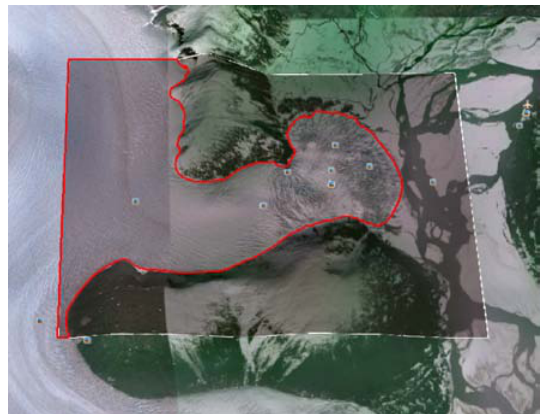
Fig. 12. Ground truth data plotted on an optical image of the scene. Red polygon: the exact glacier area derived based on the optical image (acquired in summer 2010)